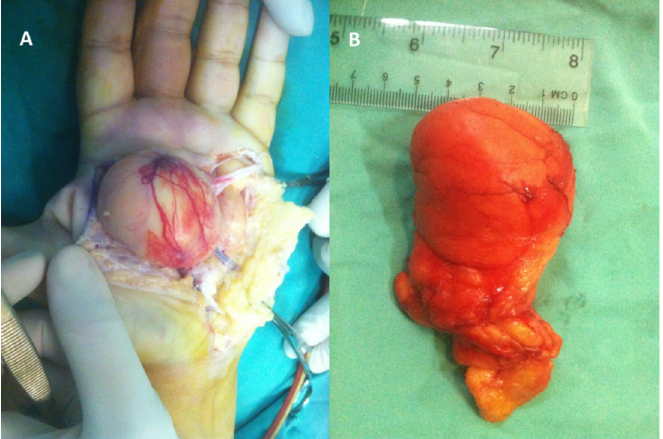
Figure 6. Large 4th finger lipoma measuring 3.7/1.7 cm: ( A ) intraoperative aspect and ( B ) removed specimen. The largest sized lipoma in the study was recorded in midpalmar space, measuring 8/5/3.5 cm and weighing 125 g (Figure 7).